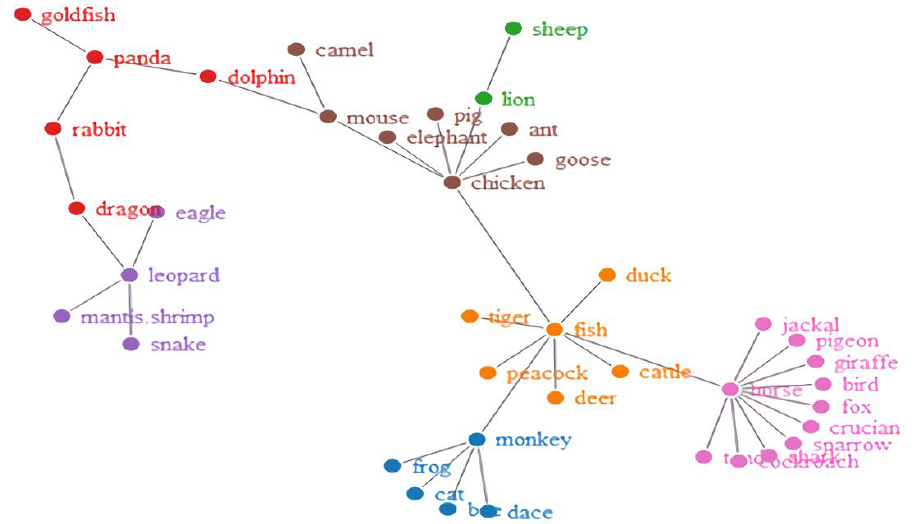
Figure 2. Network visualization of the Hakka-animal lexical network.